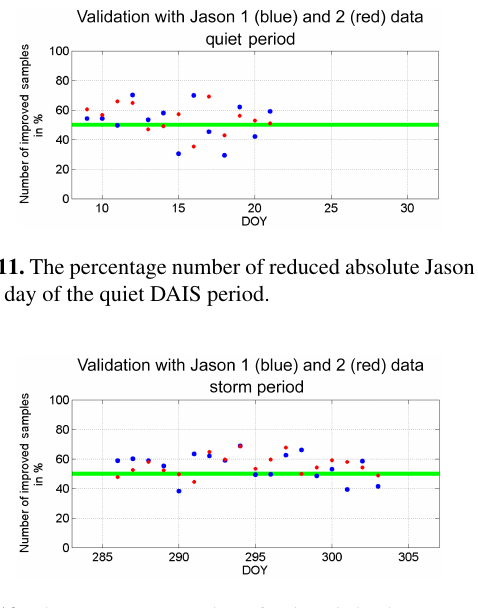
Figure 12. The percentage number of reduced absolute Jason resid- uals per day of the disturbed DAIS period.